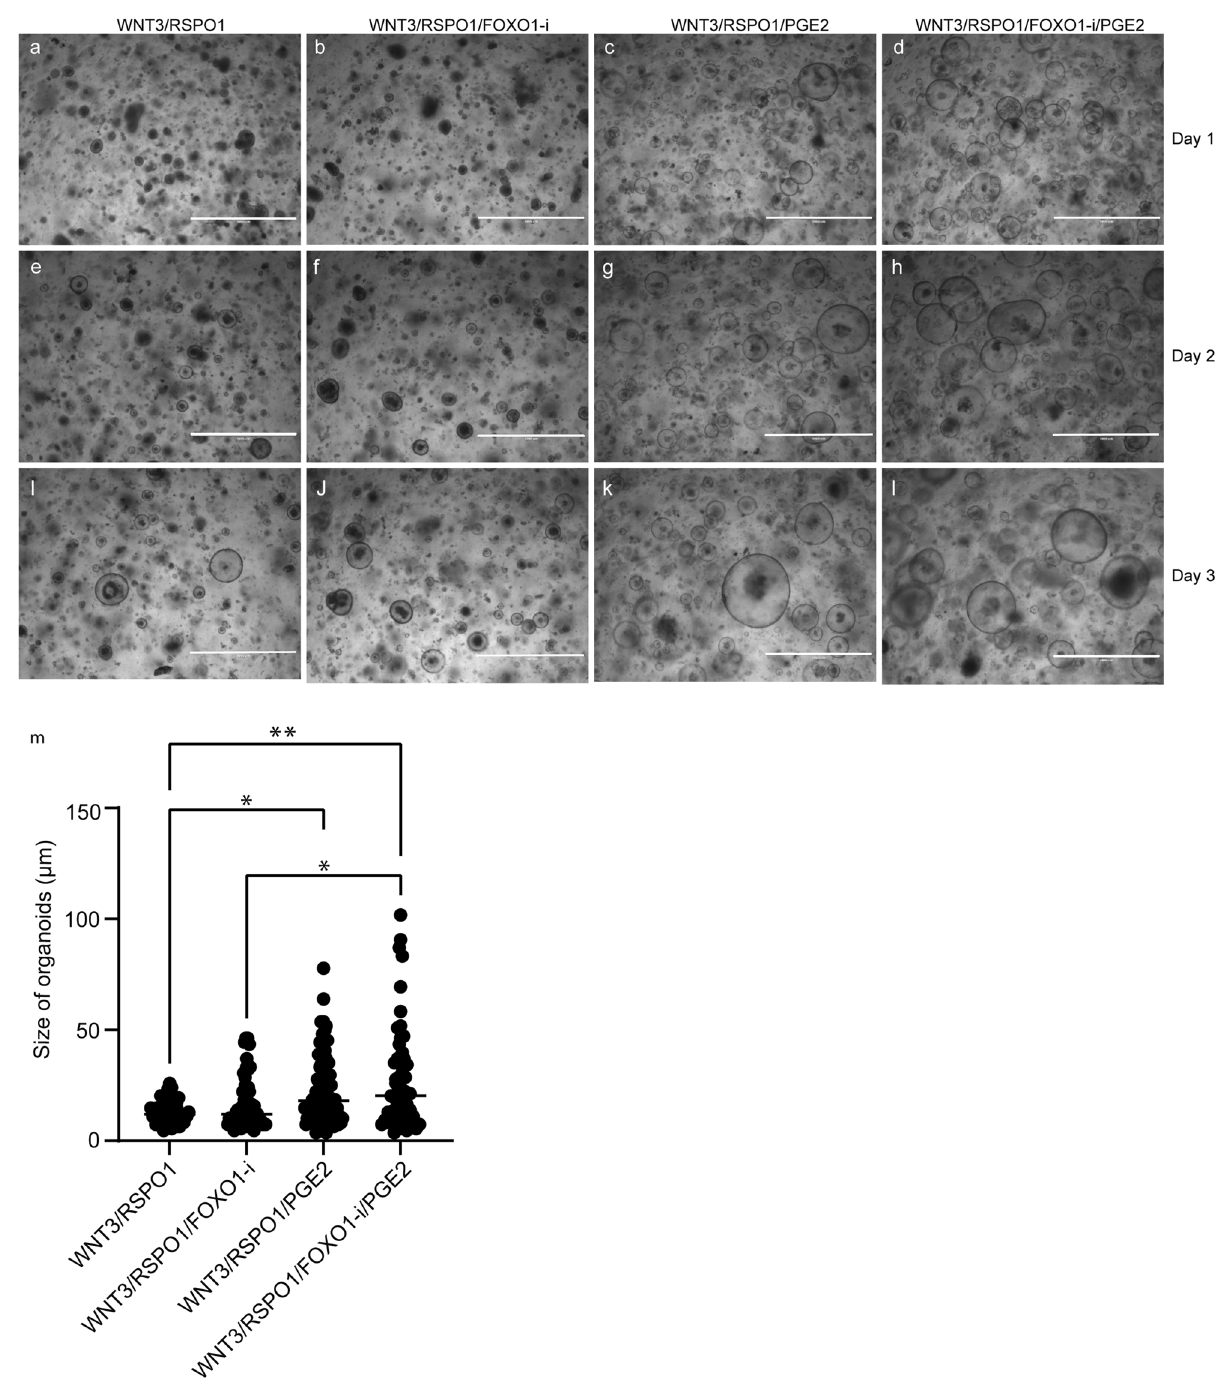
Figure 4. Supplementary compounds for organoid growth. Brightfield images of embryonic chicken organoid cultured in Matrigel with BCM of passage 1, 1,2 and 3 days after splitting. ( a,e,i) with additional RSPO1 and WNT3 of chicken origin. ( b,f,j) with additional RSPO1/WNT3 of chicken origin and 0.2 µM Forkhead box O1-inhibitor (FOXO1-i). ( c,g,k) with additional RSPO1/WNT3 and 2.5 µg/ml prostaglandin E2 (PGE2) ( d,h,l) . With all 4 supplemented growth factors (WNT3/RSPO1/PGE2/FoxO1-i). Images are representative of three independent cultures. Scale bar: 1000 µm. (m) Diameter of organoids when culturing with different supplements, were measured manually and plotted in Graphpad Prism. Four outliers were excluded after performing an outlier test in Graphpad Prism. Statistics were performed using a Kruskal–Wallis test followed by Dunn’s multiple comparisons test. *p < 0.05 **p <